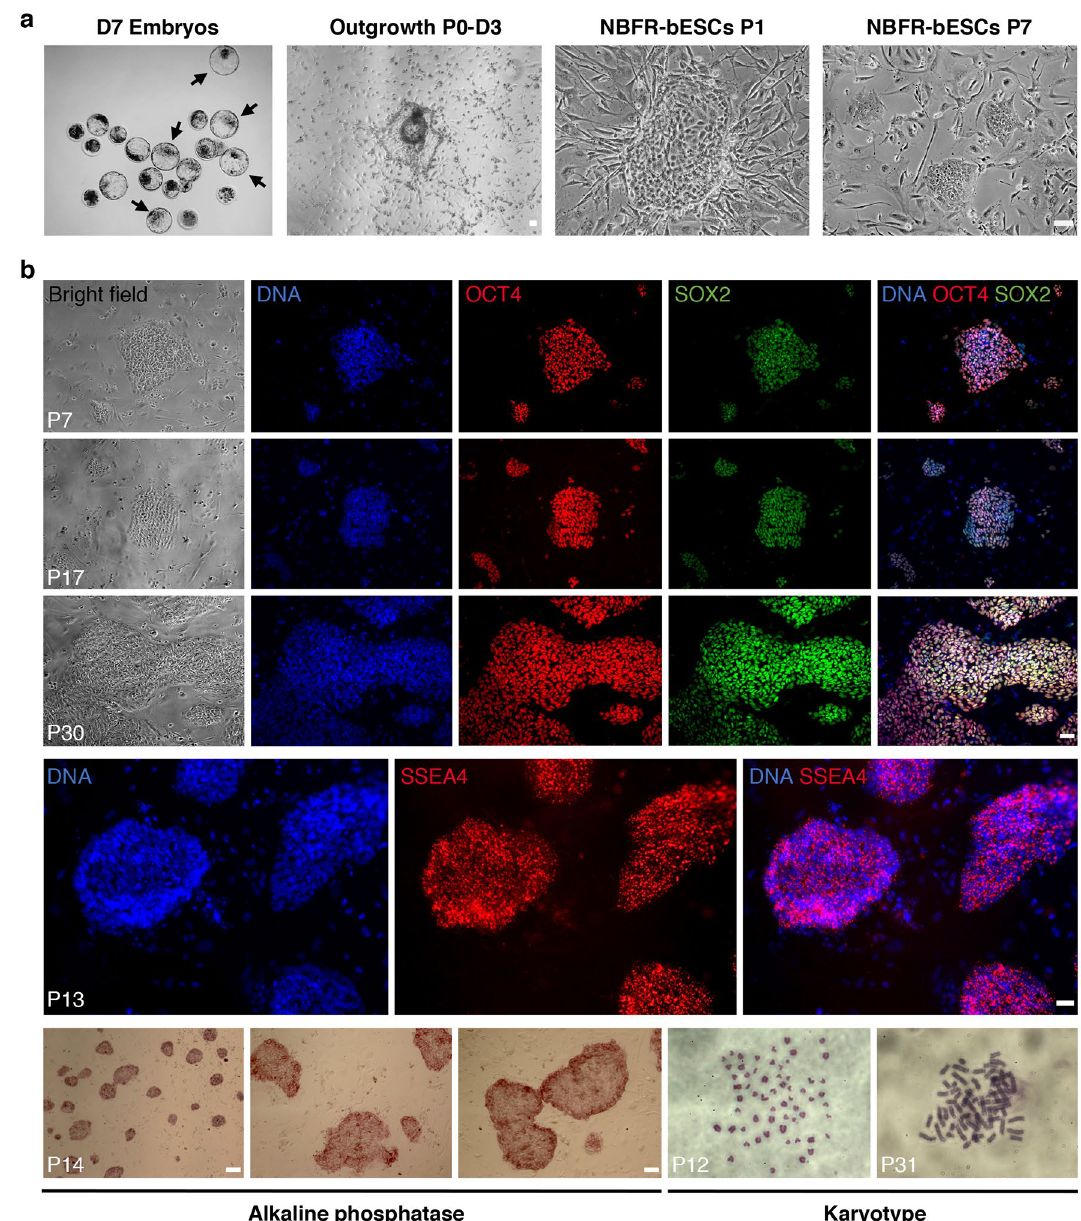
Figure 1. Derivation and characterization of bESCs in NBFR conditions. ( a ) Bright field images at different stages of bESC derivation from whole blastocysts. Images represent day-7 embryos selected for ESC derivation (arrows), outgrowth after 3 days in culture, and typical colony morphology at passages 1 and 7. ( b ) Immunofluorescence staining of OCT4 and SOX2 pluripotency factors, and SSEA4 surface marker. Detection of alkaline phosphatase activity, and chromosome number (2n = 60) of bESCs at different passages. D: day; P: passage. Scale bars 100 state (Fig. 2c) 26 . All together, we concluded that NBFR culture medium supports derivation and self-renewal of pluripotent bESCs with molecular similarities to CTFR-bESCs and the primed pluripotency state. NBFR‑bESCs undergo multilineage commitment in vitro and in vivo. as EBs, endodermal ( FOXA2 and SOX17 ), mesodermal ( CDX2 ), and ectodermal genes ( PAX6 ) were progres- sively upregulated (Fig. 3b). For teratoma evaluation, one male (NBFR-bESCs #D) and one female (NBFR-bESCs #Y) cell lines were injected into immunodeficient mice. After 12 weeks, each cell line resulted in the formation of one teratoma similar in size (~ 2 cm in diameter) containing tissues representative of the three germ layers (Fig. 3c). These results indicate that NBFR-bESCs have the capacity to differentiate into derivatives of the three germ lineages, thereby demonstrating their pluripotent status.